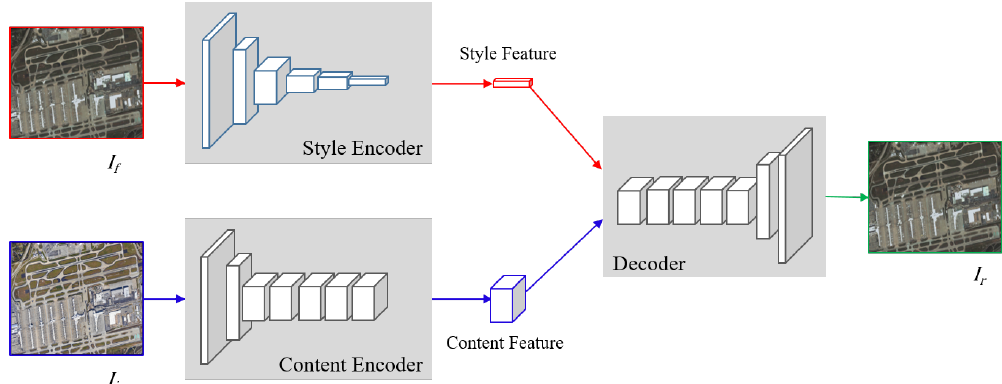
Figure 4. The flowchart of generating a synthetic reference image by using a historical image and the target frame.